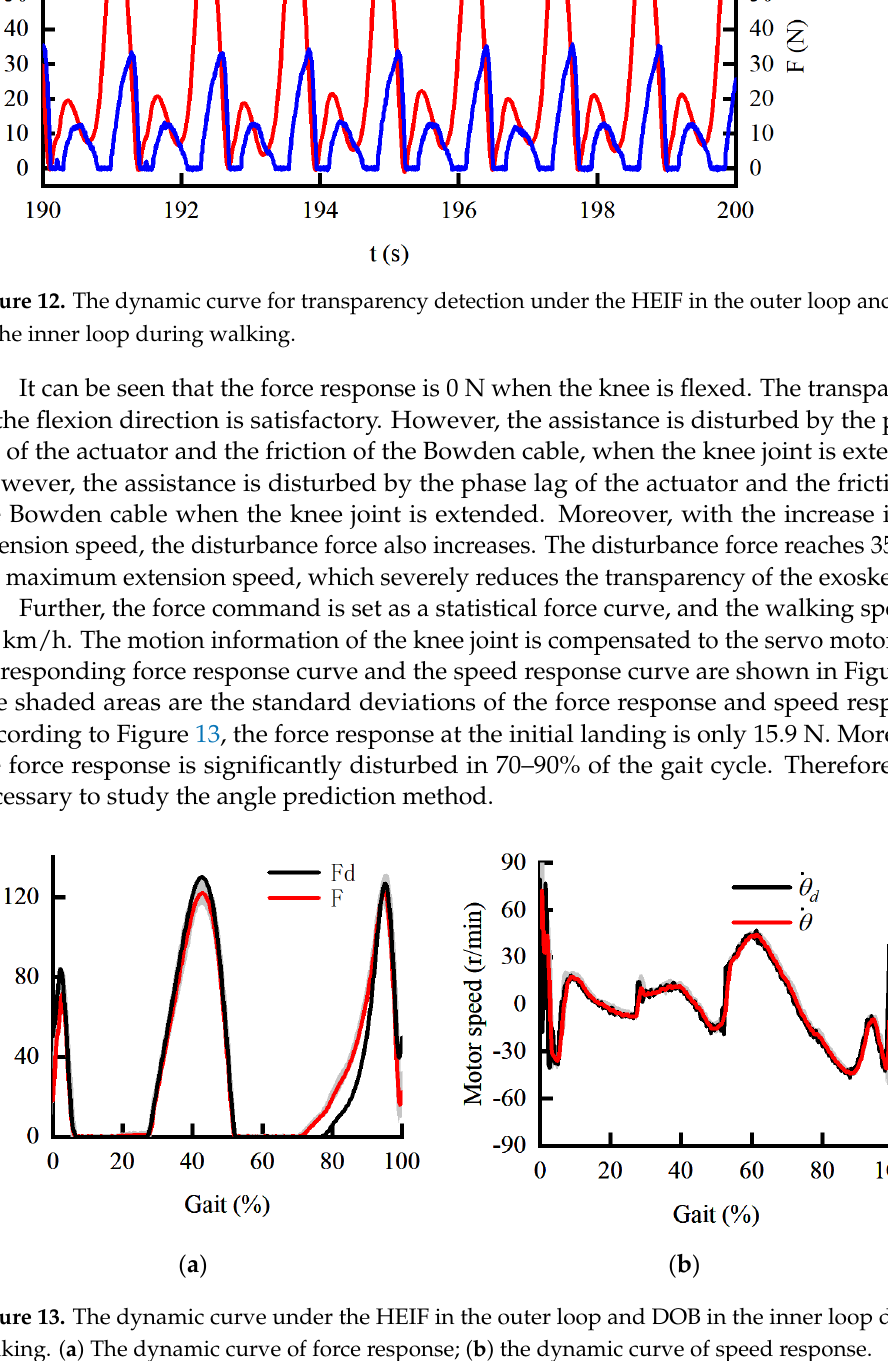
( b ) Figure 11. The dynamic curve under the HEIF in the outer loop and DOB in the inner loop. ( a ) The dynamic curve of force response; ( b ) the dynamic curve of speed response.